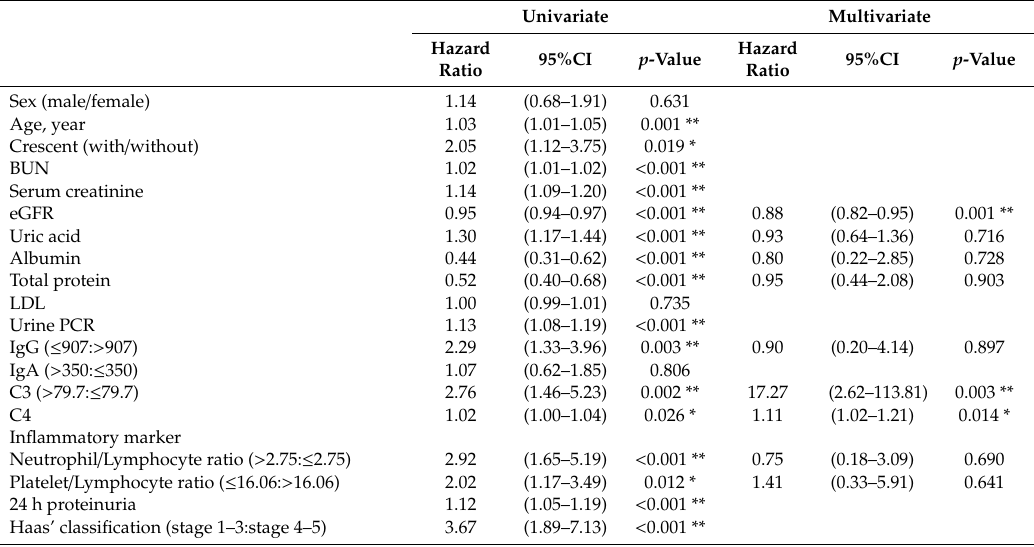
Table 2. Cox regression models for renal survival via univariate and multivariate analysis.